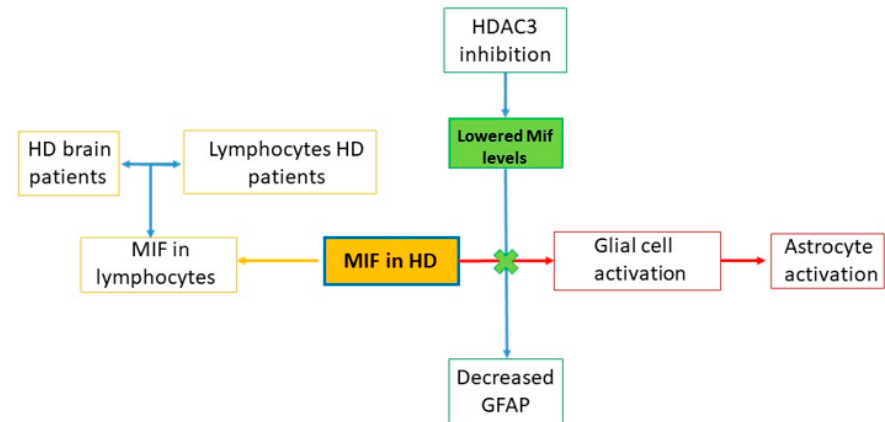
Figure 3. MIF in HD. Preclinical studies on MIF in HD show that lymphocytes of HD patients express MIF against a single agent present in brain samples of HD patients [59]. It has also been observed that MIF down expression, through the inhibition pathway of HDAC3, reduces the activation of the astrocytic response [60].